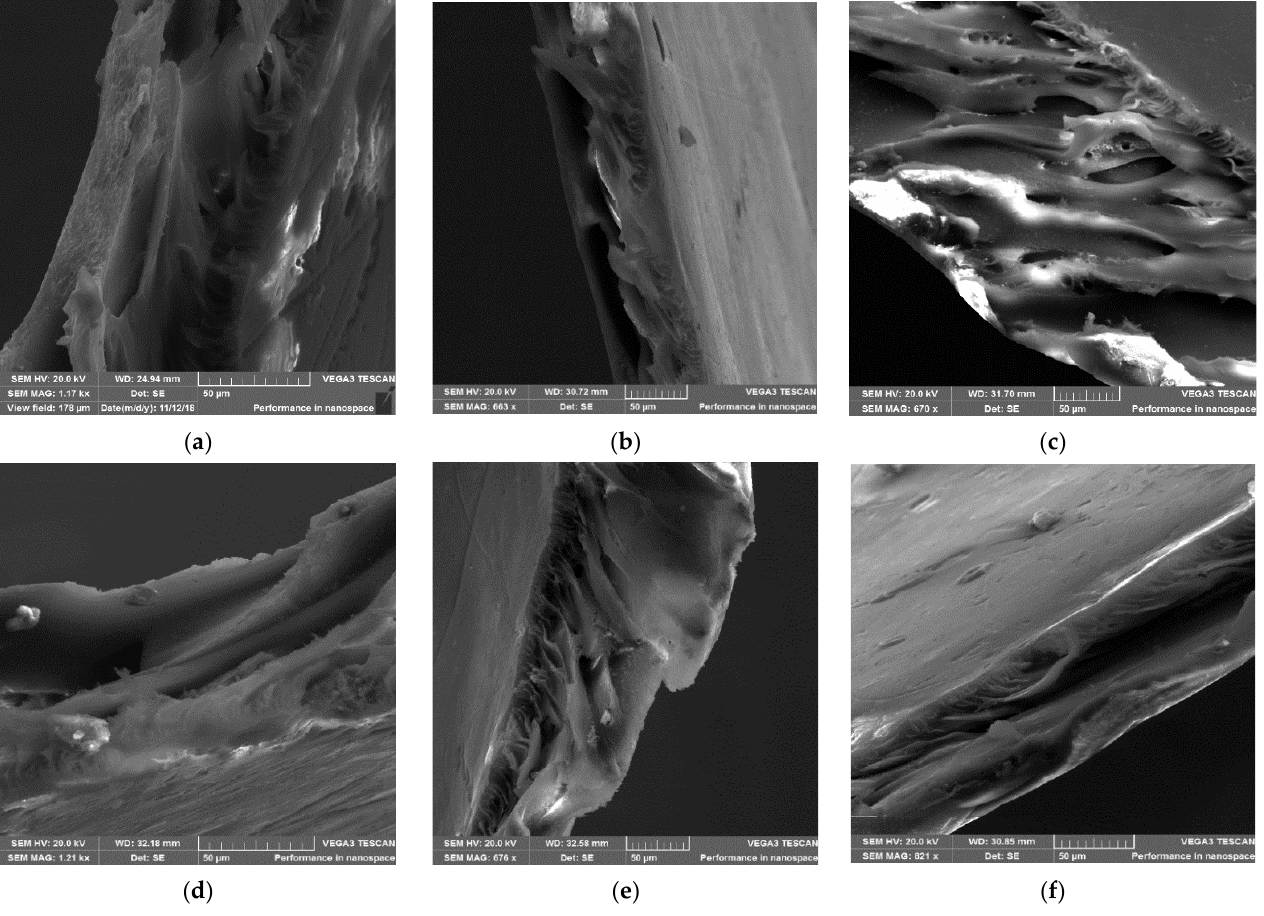
Figure 5. SEM cross-sectional of C60-ZSM-22/PES membrane materials prepared using C60-ZSM- 22 as zeolite additives: ( a ) PES, ( b ) 0.1 wt.% C60-ZSM-22/PES, ( c ) 0.3 wt.% C60-ZSM-22/PES, ( d ) 0.5 wt.% C60-ZSM-22/PES, ( e ) 0.75 wt.% C60-ZSM-22/PES, and ( f ) 1.0 wt.% C60-ZSM-22/PES via phase